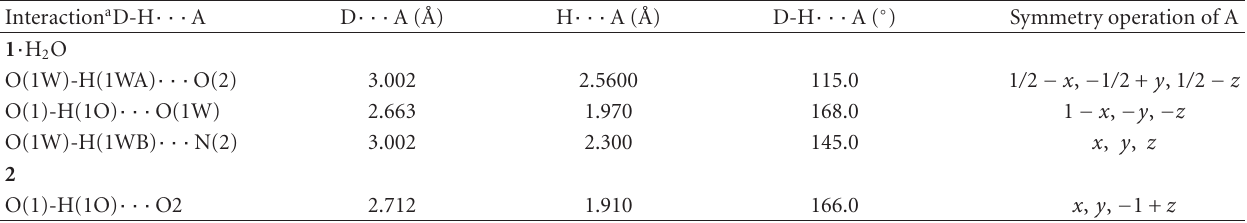
Table 4: Hydrogen bonding interactions in 1 · H 2 O and 2 .